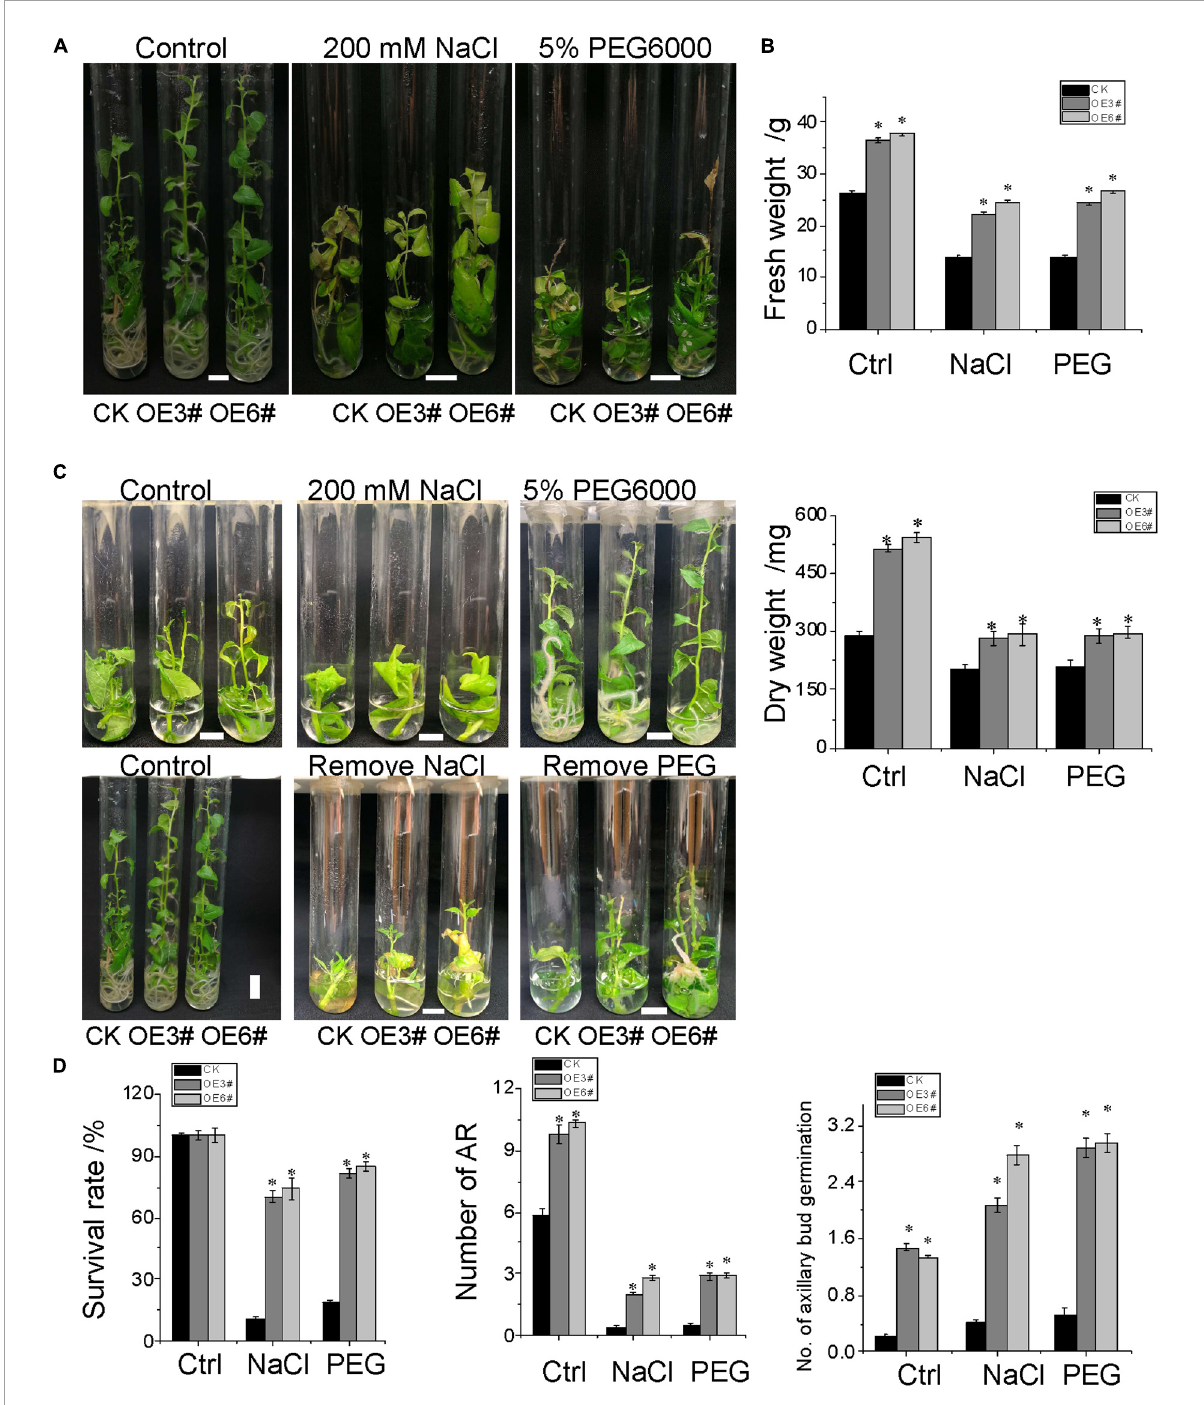
FIGURE7 Stress response of JrWOX11 -transgenic “84K” plants. (A) The growth and phenotype of JrWOX11 -transgenic and WT poplar plants. (B) Effects of salt and osmotic stress on fresh weight and dry weight. Four-week-old seedlings were cultured vertically on the liquid RIM medium (1/2MS + 0.01 mg · L - 1 of IBA + 30 g · L - 1 of sucrose) supplemented with 200 mM NaCl or 5% PEG6000 for 2 weeks. (C) The photographs were taken, and the fresh weight and dry weight of each plant were measured. (D) The survival rate and regeneration response were observed when NaCl and PEG were removed. About 2.5 cm shoot cuttings were cultured vertically on liquid RIM medium supplemented with 200 mM NaCl or 5% PEG6000 for 4 weeks, then were transferred to liquid RIM medium without NaCl and PEG6000 for 2 weeks. The photographs were taken, the survival rate and the number of axillary bud regeneration, and the number of ARs of each plant were measured. All the above data were represented as the mean ± SD of at least three independent replications. Asterisk indicates a significant difference ( ∗ P < 0.05) between transgenic lines and WT